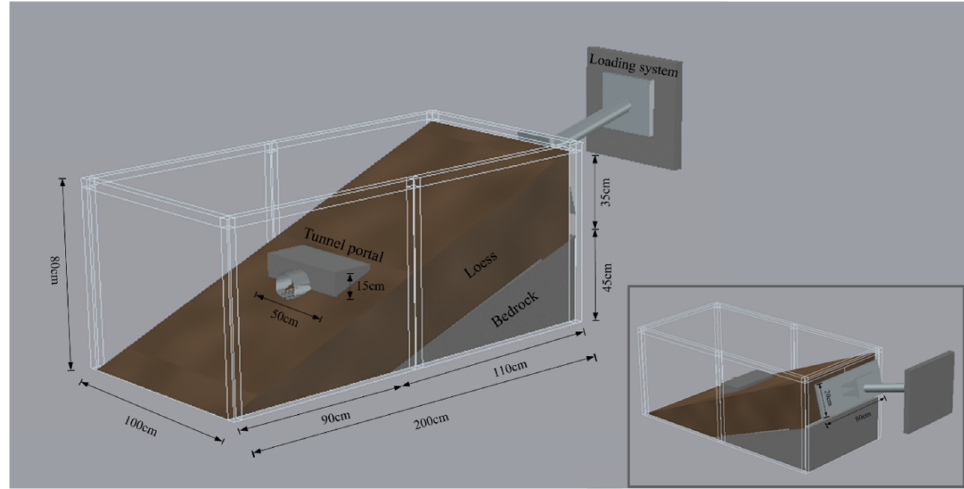
Figure 1. Schematic of the test